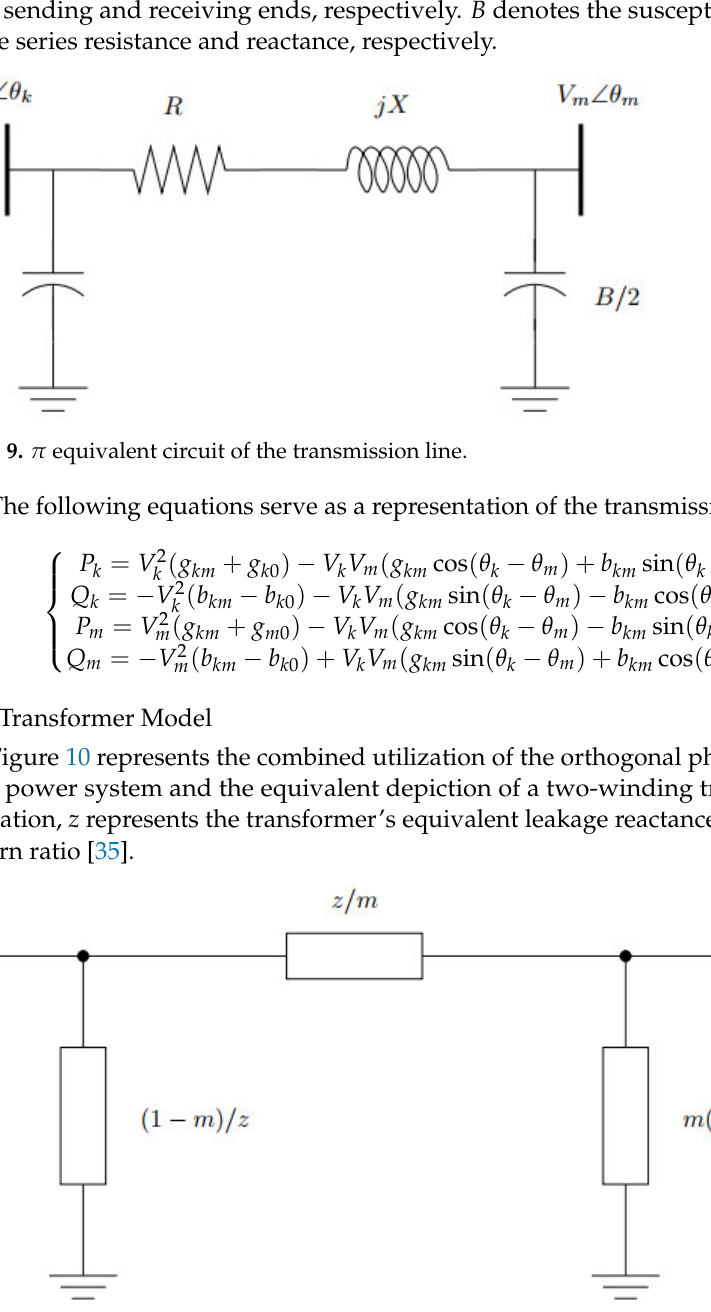
Figure 8. PID battery controller.